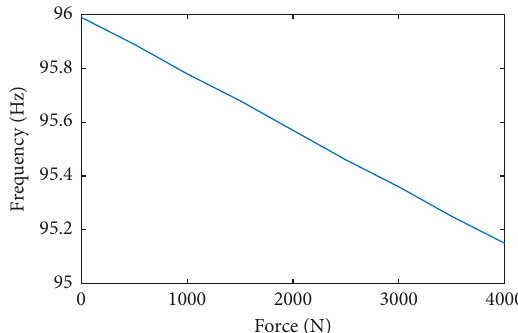
Figure 8: First natural frequencies of ball screw under different forces ( d � 0 . 02 m, force position is 0 . 3 L